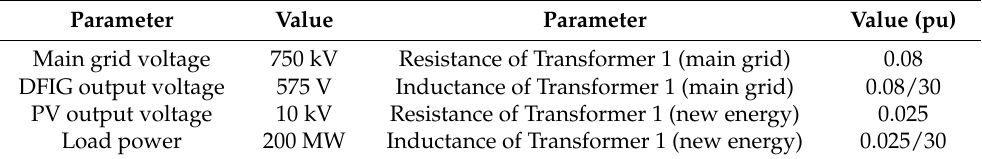
Figure 2. Simulation model. Table 1. Parameters of the